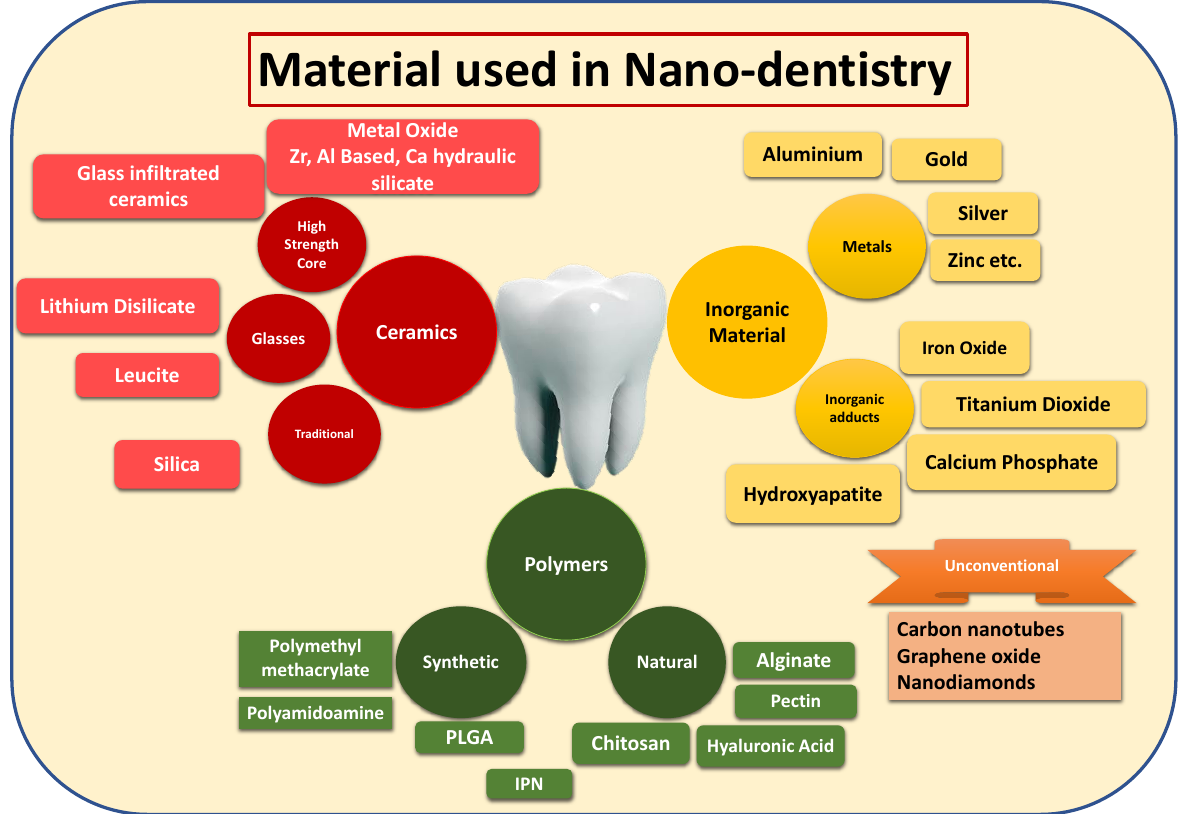
Figure 3. Diagrammatic illustration to provide basic material classes used in dentistry.